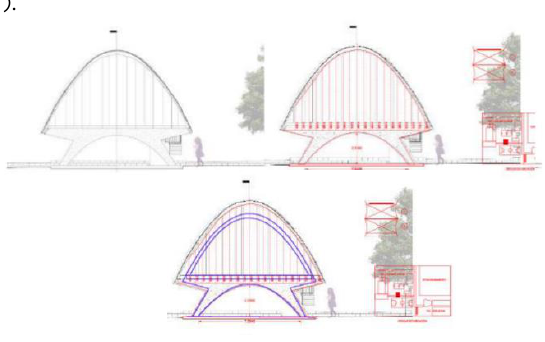
Figure 20. Top Left : 2D drawing done by Rajabzadeh using Revit software and point cloud data. Top Right : In red: Cordero’s drawing is overlaid. Bottom In blue: Original construction drawing by Candela) are